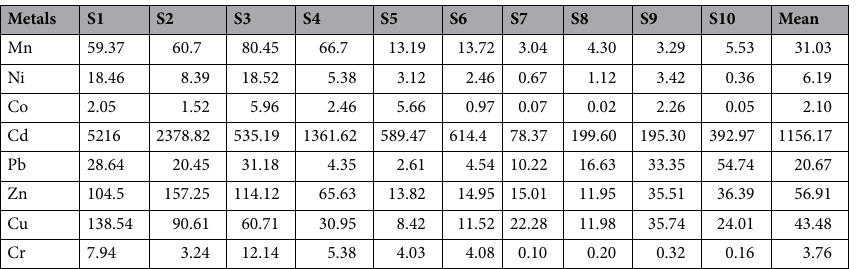
Table 6. Enrichment factors for analyzed